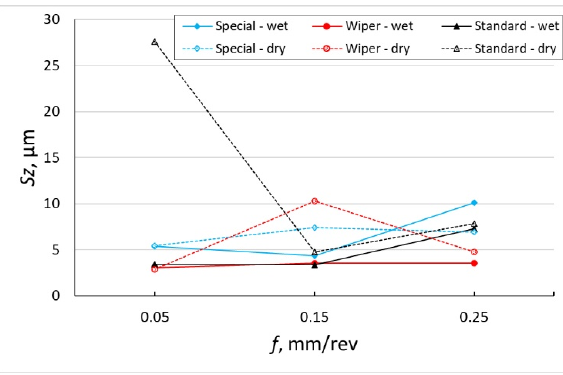
Figure 6. The impact of feed f on the variability of roughness parameter Sz .